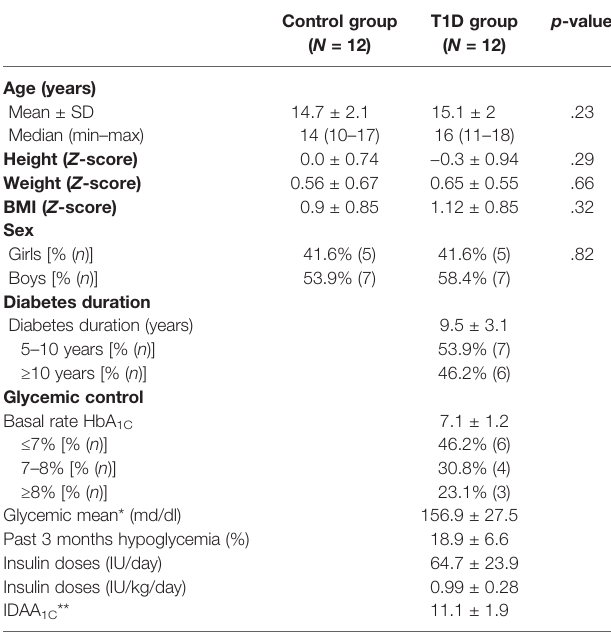
TABLE 1 | Characteristics of the clinical